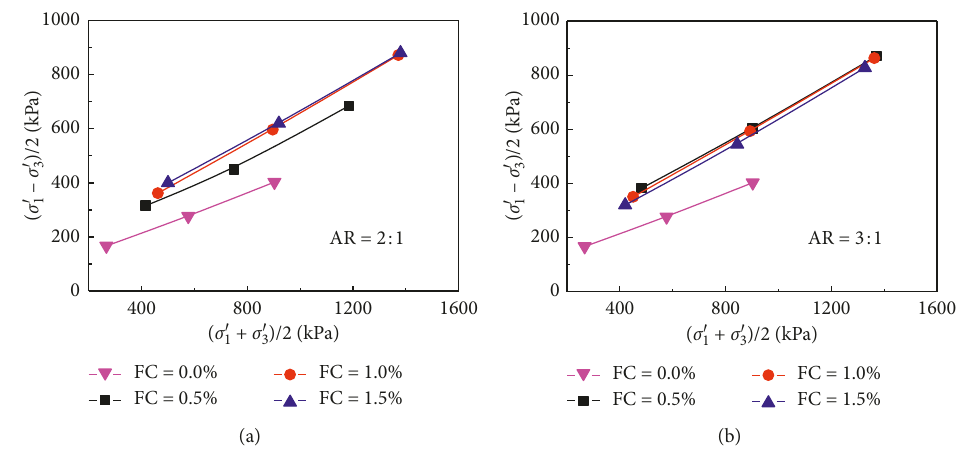
Figure 10: Residual shear strength envelope: (a) aspect ratio of 2:1; (b) aspect ratio of 3 :1.